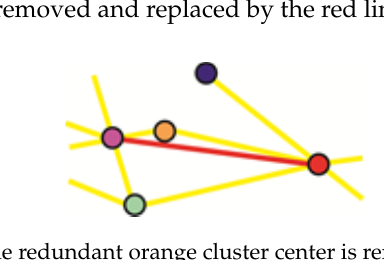
Figure 5. The redundant orange cluster center is removed in step D.